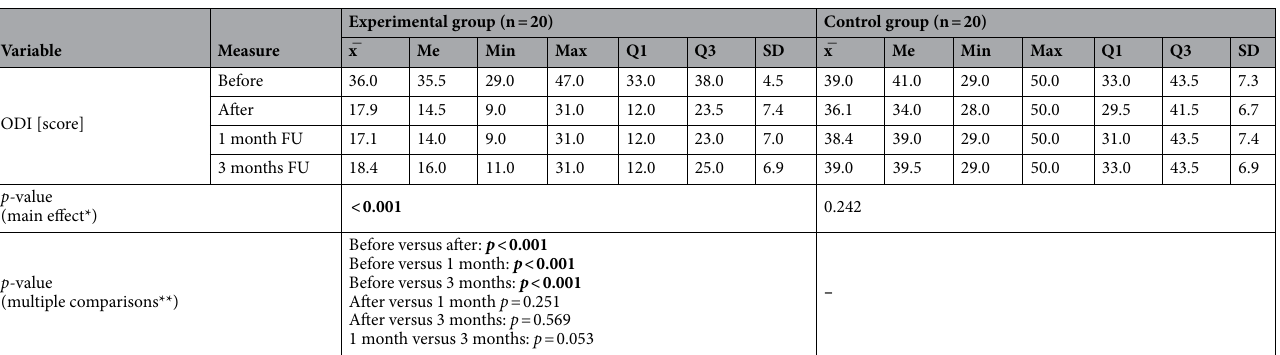
Before versus after: p < 0.001 Before versus 1 month: p < 0.001 Before versus 3 months: p < 0.001 After versus 1 month p = 0.251 After versus 3 months: p = 0.569 1 month versus 3 months: p = Table 3. The ODI scores in both groups. Significant values are in [bold]. n number of individuals, x ̅ , mean, Me median, Min minimum value, Max maximum value, Q1, lower quartile; Q3, upper quartile; SD standard deviation, FU follow-up. *Friedman’s ANOVA; **Dunn’s test.